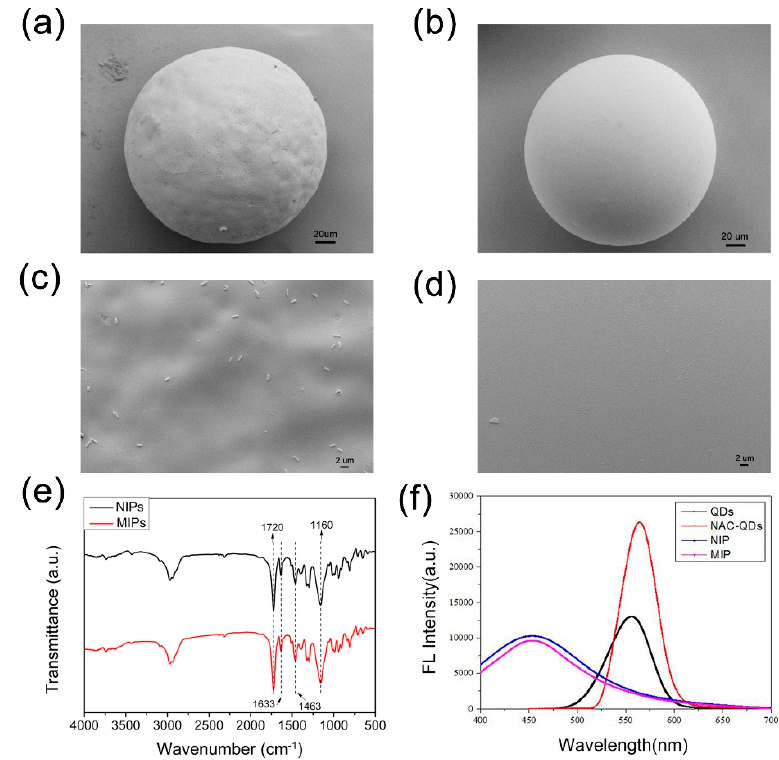
Figure 3. Characterization of polymers. Scanning electron microscopy (SEM) images of ( a ) MIPs and ( b ) NIPs which correspond to magnified SEM images of ( c ) MIPs and ( d ) NIPs, respectively; ( e ) Fourier transform infrared (FT-IR) spectra of MIPs and NIPs; and ( f ) fluorescence emission spectra of the QDs, NAC-QD complex, MIPs, and NIPs.